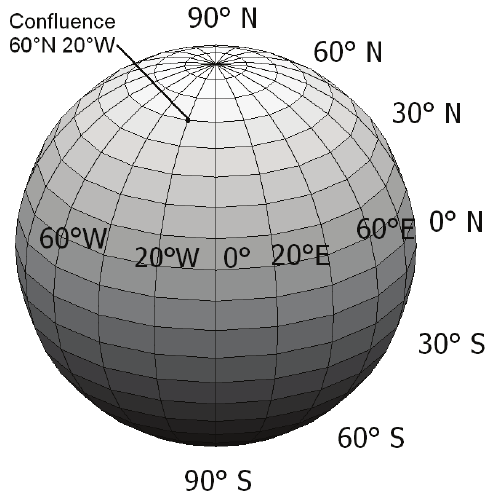
Fig. 5. Grid with Geographical Coordinate Lines